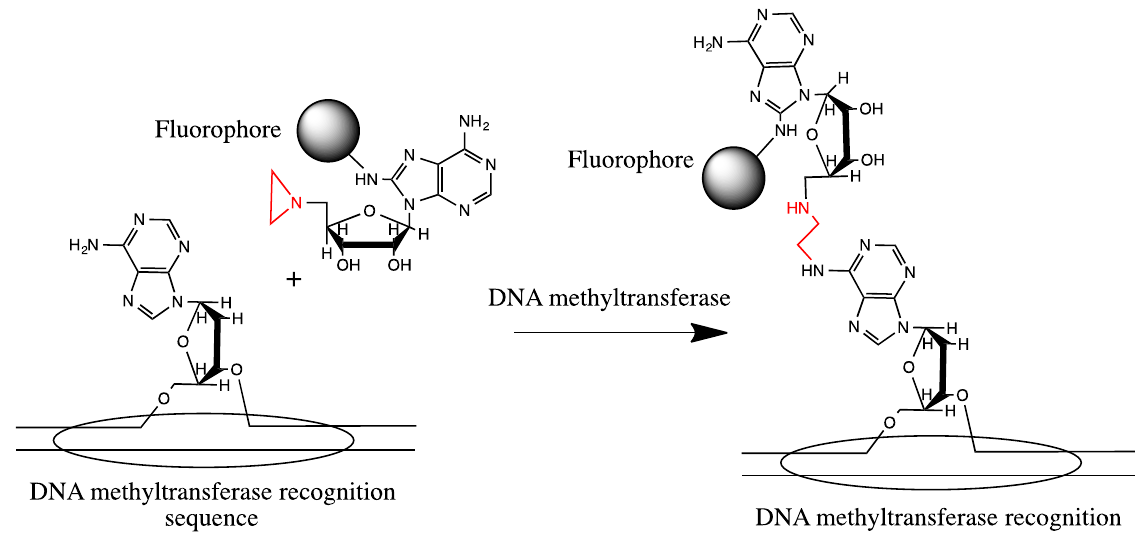
Figure 2. DNA sequence-specific labeling using DNA methyltransferase and fluorescent aziridinyl derivative of adenosine as its substrate instead of S-adenosylmethionine